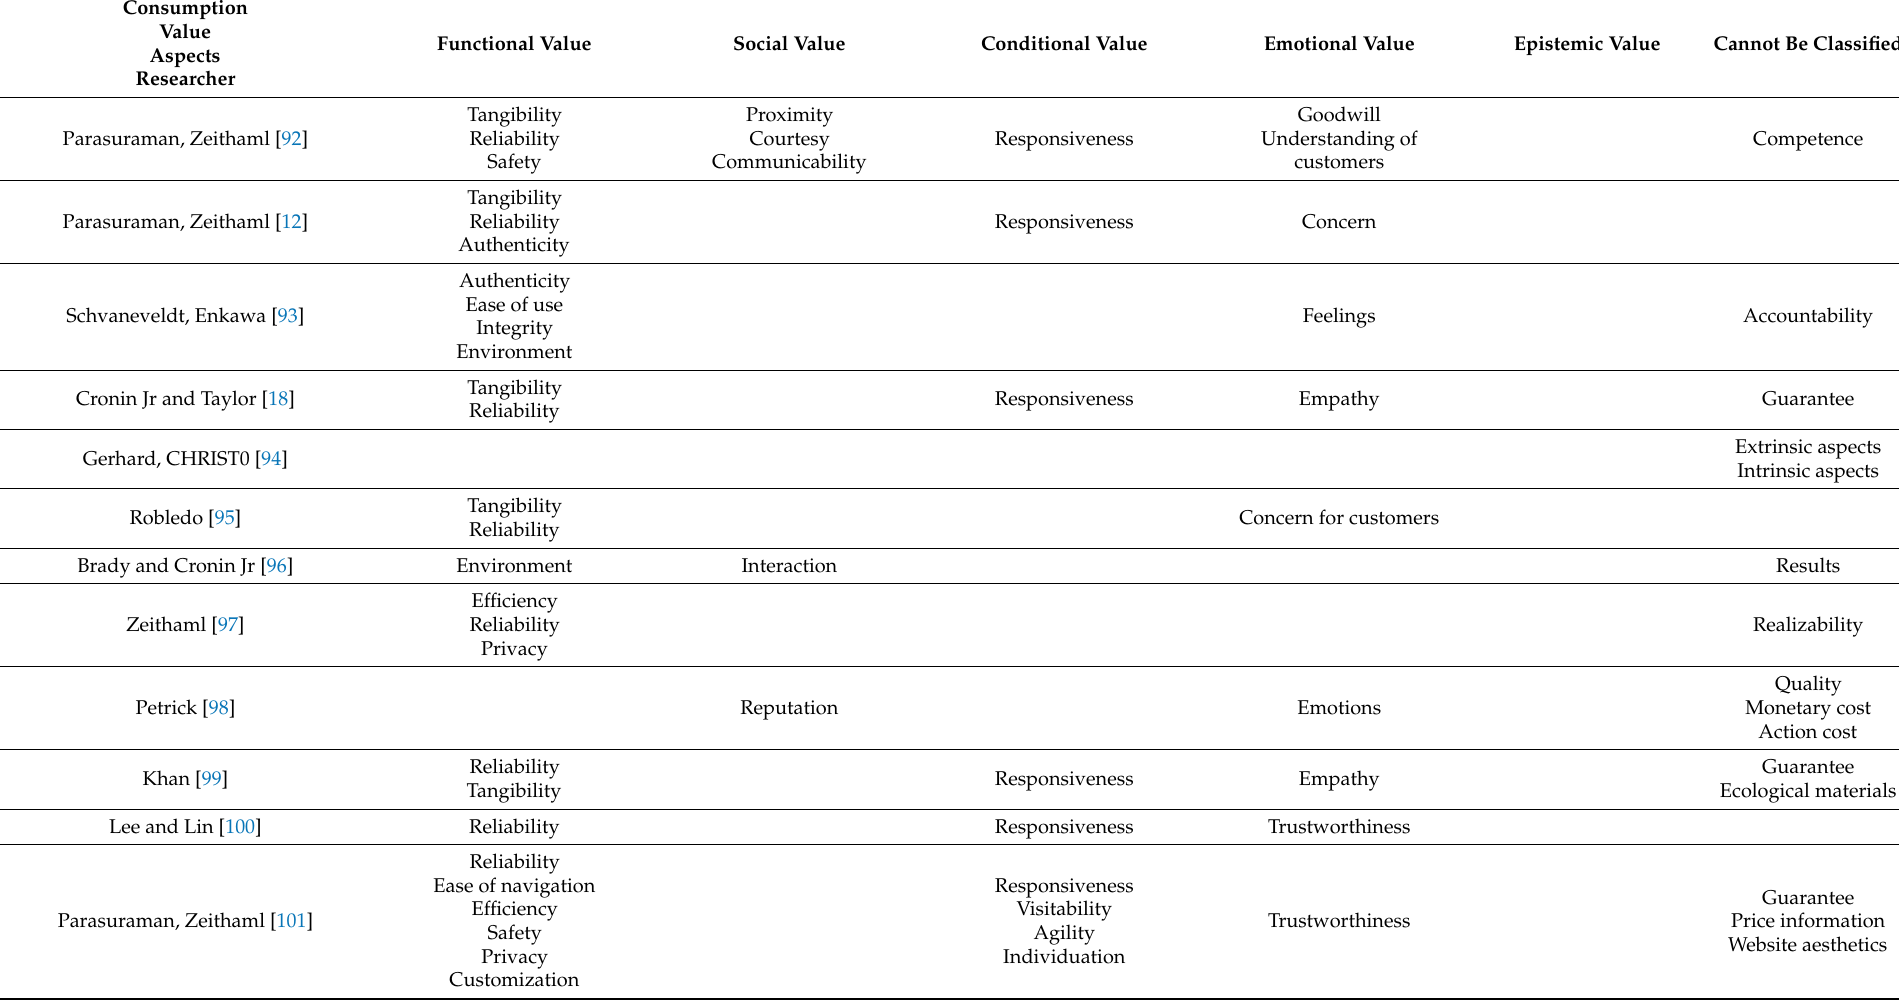
Table 2. Classification of service quality